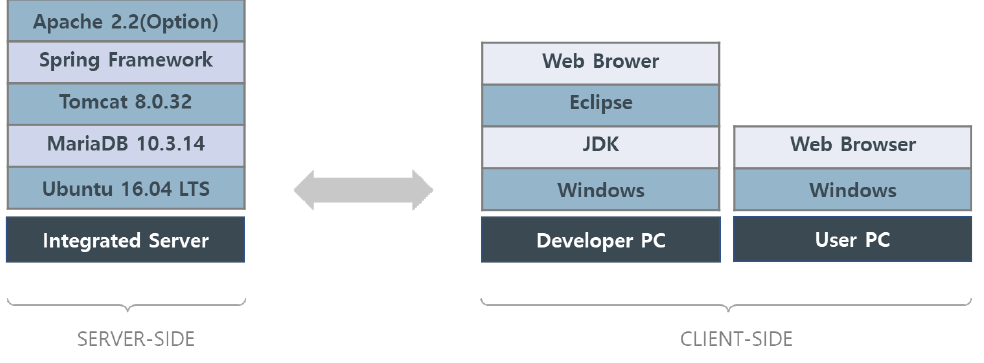
Figure 9. Configuration diagram of the test environment. The network configuration of the test environment is shown in Table 7. Table 7. Network configuration of the test environment.